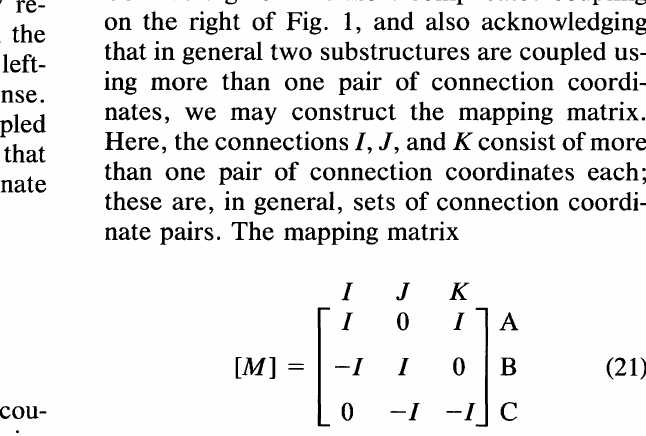
FIGURE 1 Substructure couplings and directed